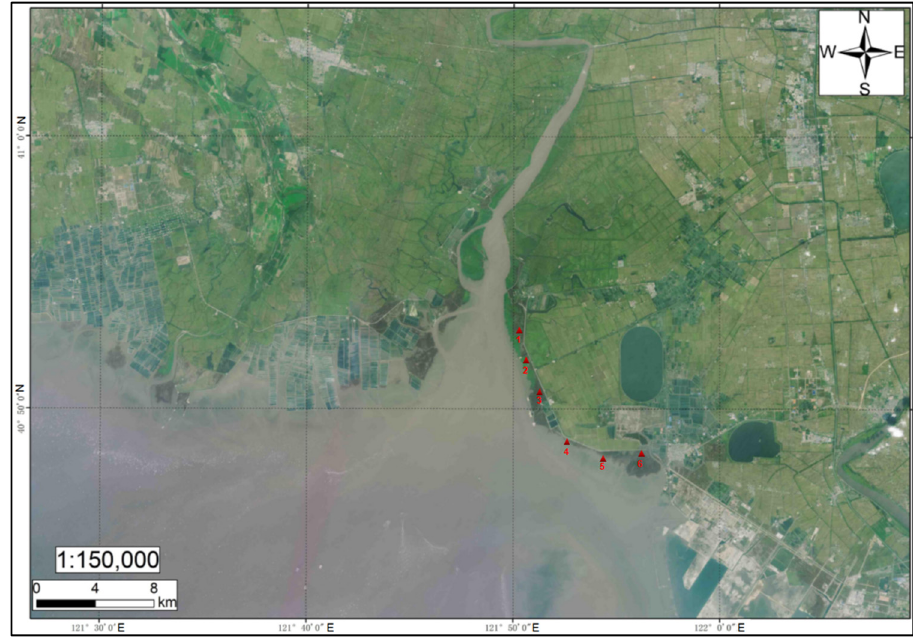
Figure 1. The location of sampling points.